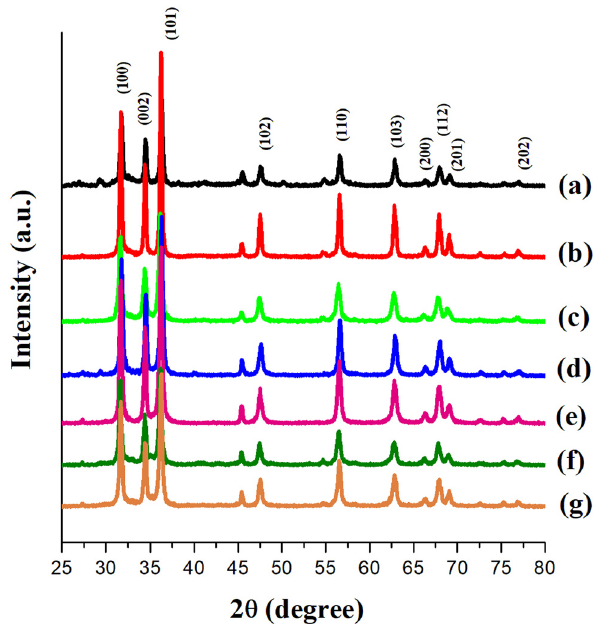
Figure 3: XRD pattern of: ( a ) ZnO, ( b ) Fe – ZnO - 1, ( c ) Fe – ZnO - 2, ( d ) Fe – ZnO - 3, ( e ) Fe – ZnO - 4, Fe – ZnO - 5, and ( g ) Fe – ZnO - 7.